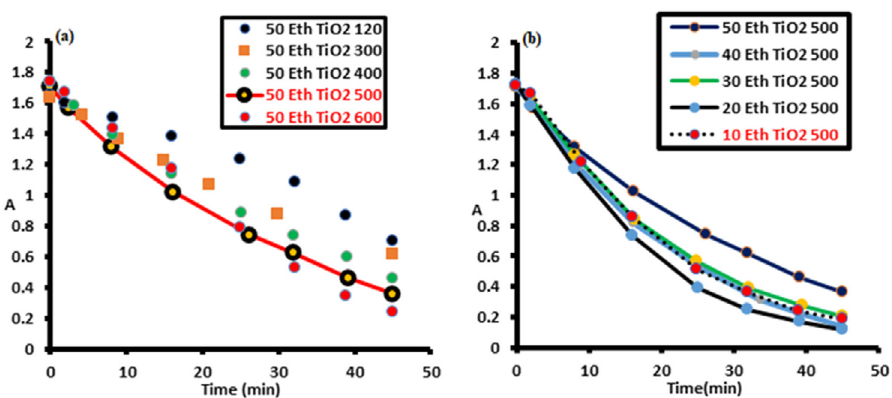
Fig. 11. Photocatalytic degradation of E 131 VF dye in the presence of (a) TiO temperatures; (b)